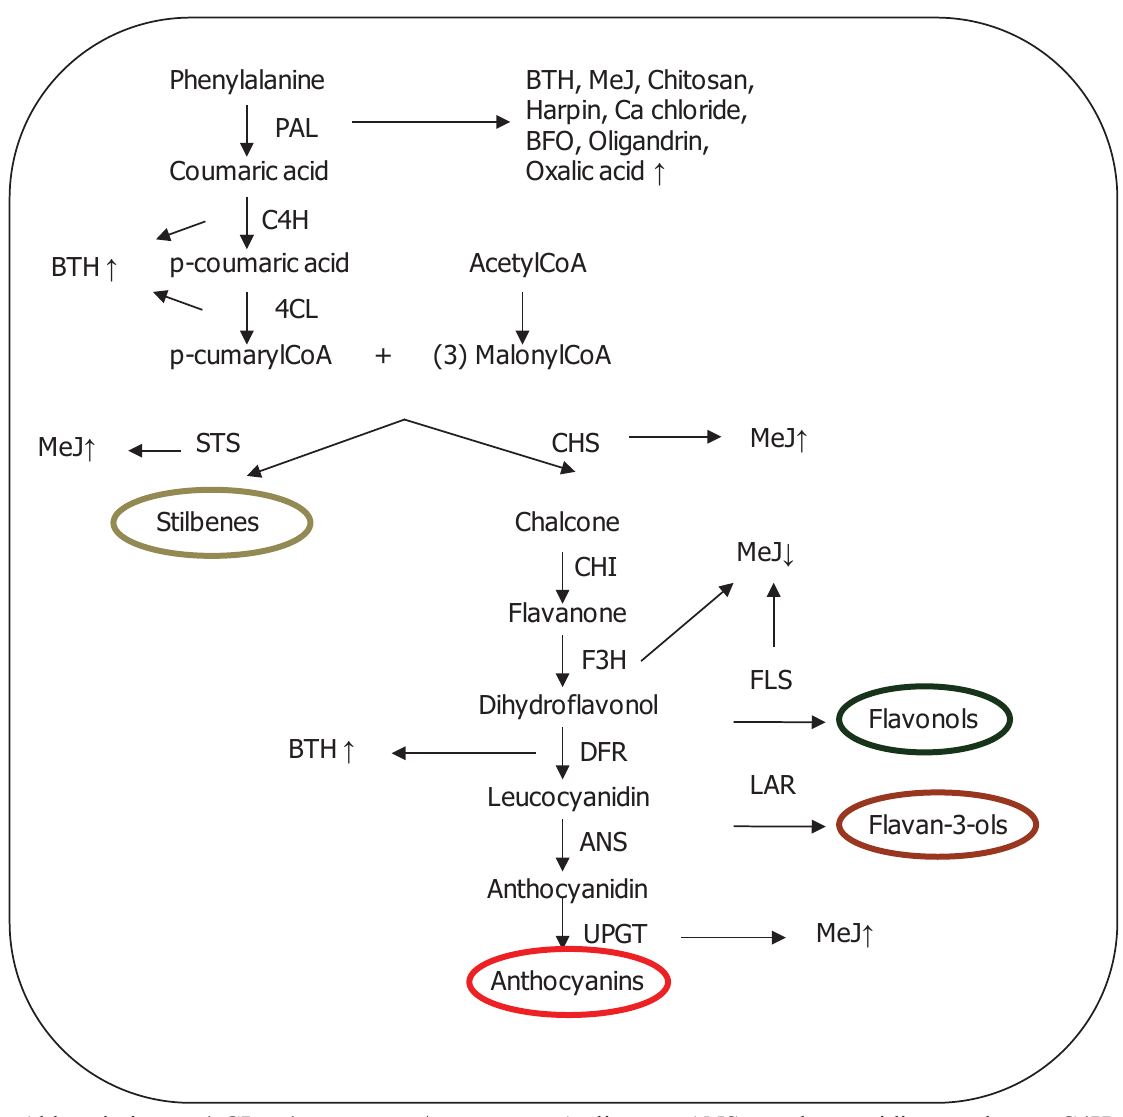
Figure 1 . Summary of polyphenol synthesis and enzyme regulation by